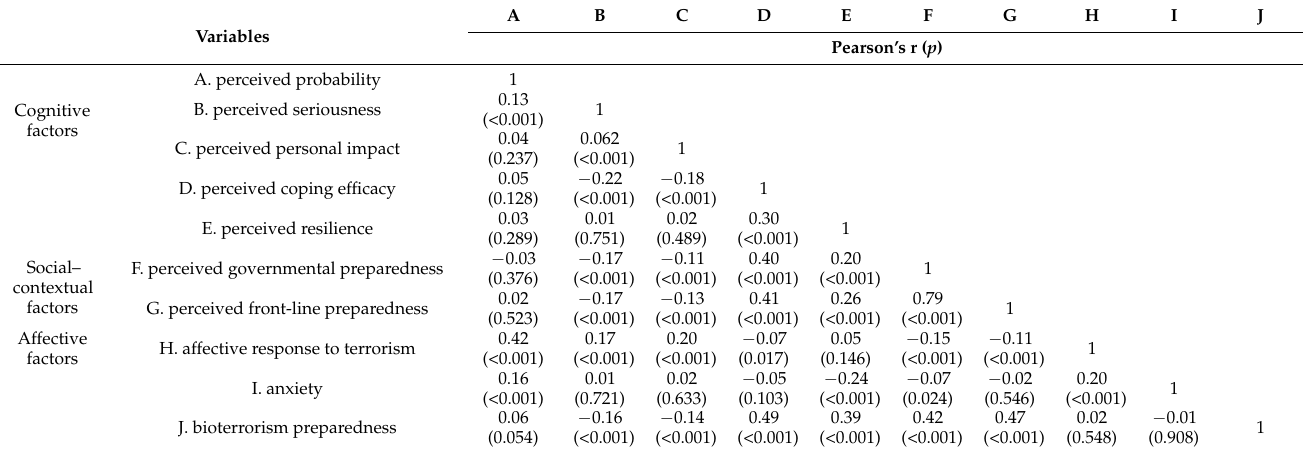
Table 3. Correlations among study